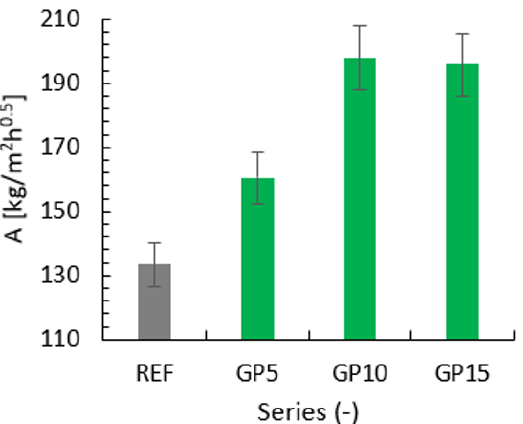
Figure 7. Water sorption coefficients for the reference series (REF) and the series with the partial replacement of cement with granite powder (GP).